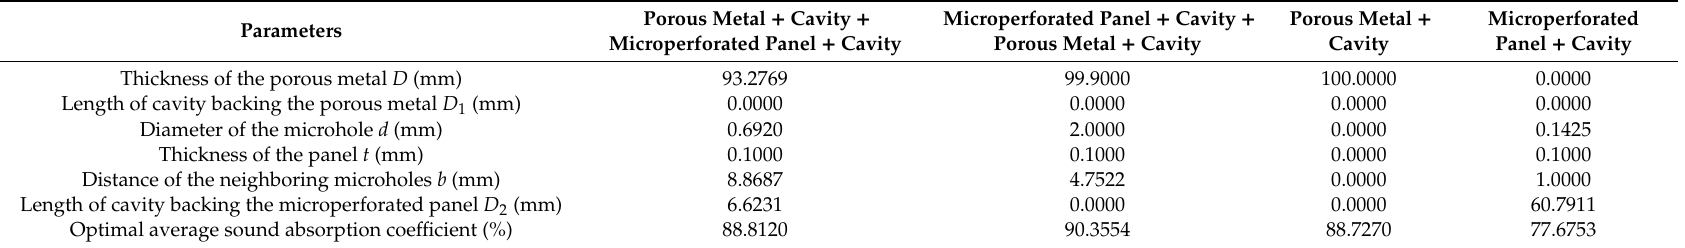
Table 3. The obtained optimal structural parameters when the limited total thickness was 100